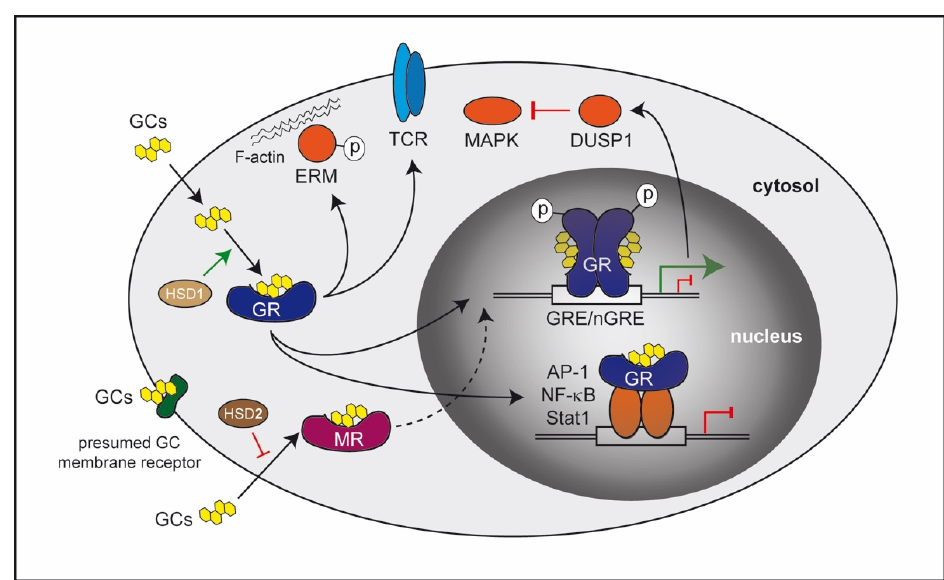
Figure 1. Molecular mechanisms of GCs involved in the control of inflammation. Natural and synthetic GCs can passively pass the cell membrane due to their lipophilic nature and bind to the GR localized in the cytosol. Here, GCs can be activated by the enzyme 11 β -HSD1, but they may also be inactivated in some cell types by 11 β -HSD2. The ligand-bound GR can directly exert its activity in the cytosol by inducing phosphorylation of ERM proteins interacting with F-actin or influence T-cell receptor (TCR) signaling. In most cases, however, the GR translocates into the nucleus, where it binds to GREs/nGREs or interacts with other transcription factors such as AP-1, NF- κ B or Stat1. As a consequence, GC-responsive target genes are either activated or repressed. Phosphorylation of the GR can additionally modulate transcriptional strength. Moreover, proteins encoded by genes that are induced by GCs such as DUSP1 can act in the cytosol and repress MAPK signaling. GCs can alternatively recognize a presumed membrane-bound receptor. Finally, they can also bind to the cytosolic MR, which is only expressed in selected cell types. In this case, the ligand-bound MR translocates into the nucleus and modulates transcription predominantly by DNA-binding-dependent mechanisms.